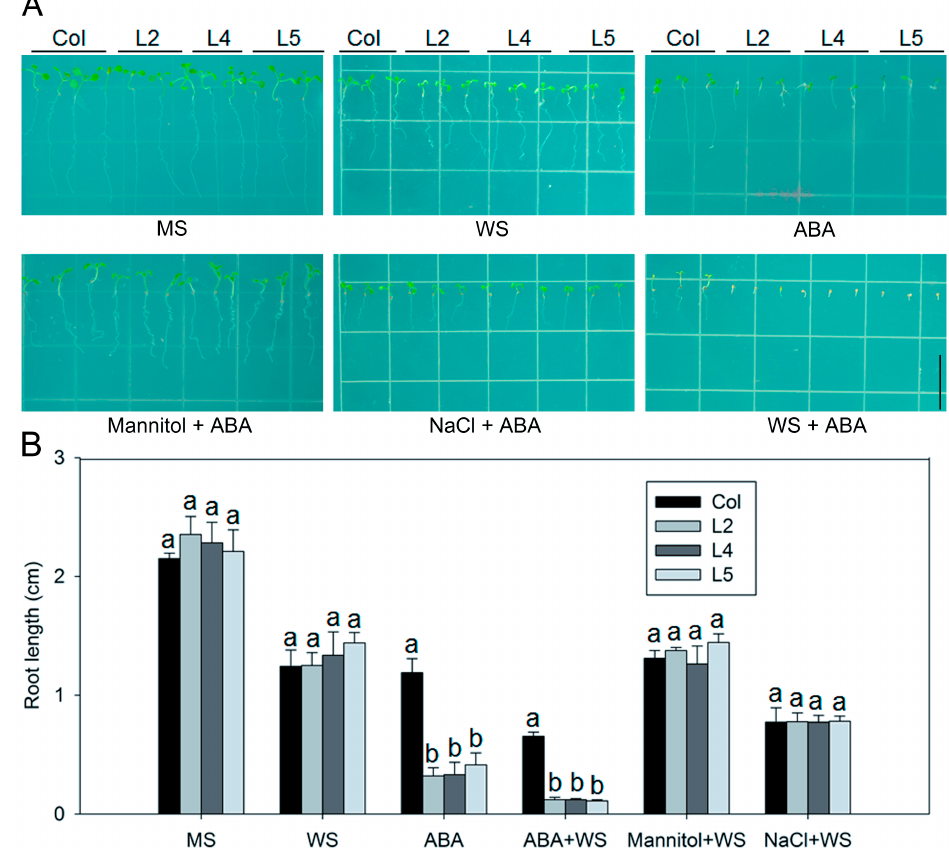
Figure 7. Cont. Figure 7.